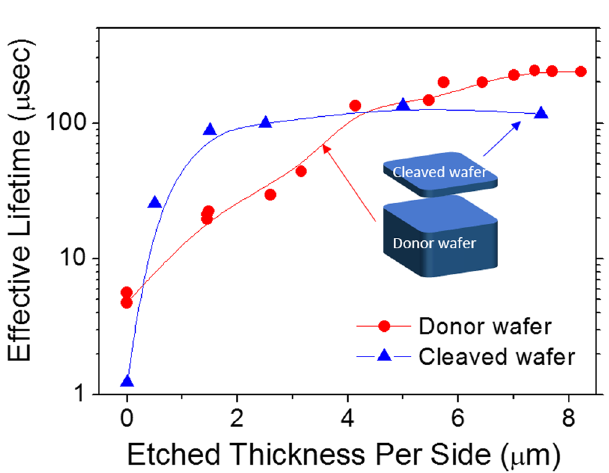
Figure 3. Effective minority carrier lifetimes of cleaved and donor wafers with wafer thinning by chemical etching of both sides of the